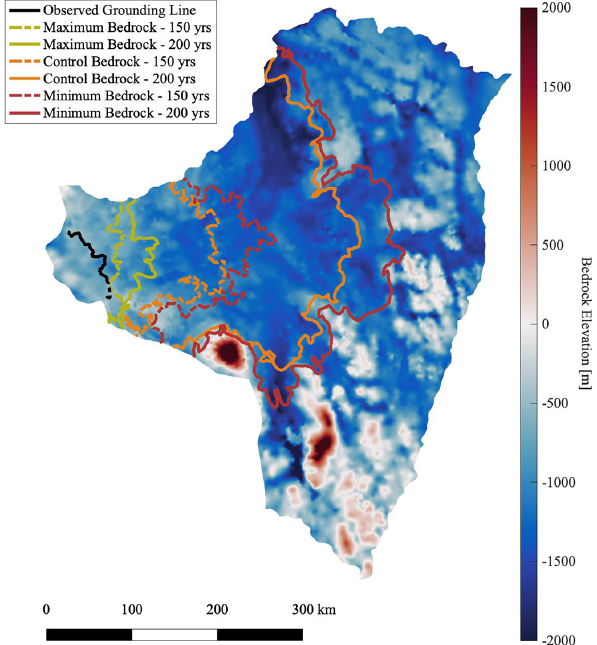
Figure 2. Results of forward model experiments using the control (orange), maximum (yellow), and minimum (red) bedrock configu- rations are shown. Two timestamps are depicted: 150 years (dashed) and 200 years (solid). At 200 years, the control, maximum, and min- imum bedrock configuration models yield 21.1, 4.8, and 26.7cm of global mean SLR respectively. The resulting SLR difference be- tween the models of minimum and maximum grounding line retreat is 21.9cm. See the Appendix (Sect. A3) for the 150- and 200-year tabulated SLR